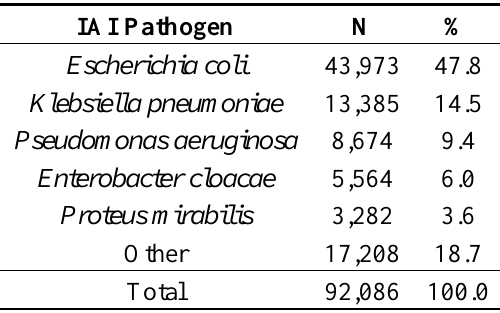
Table 1. Top five most prevalent Gram-negative bacteria associated with intra-abdominal infections from SMART between 2002 and 2011.